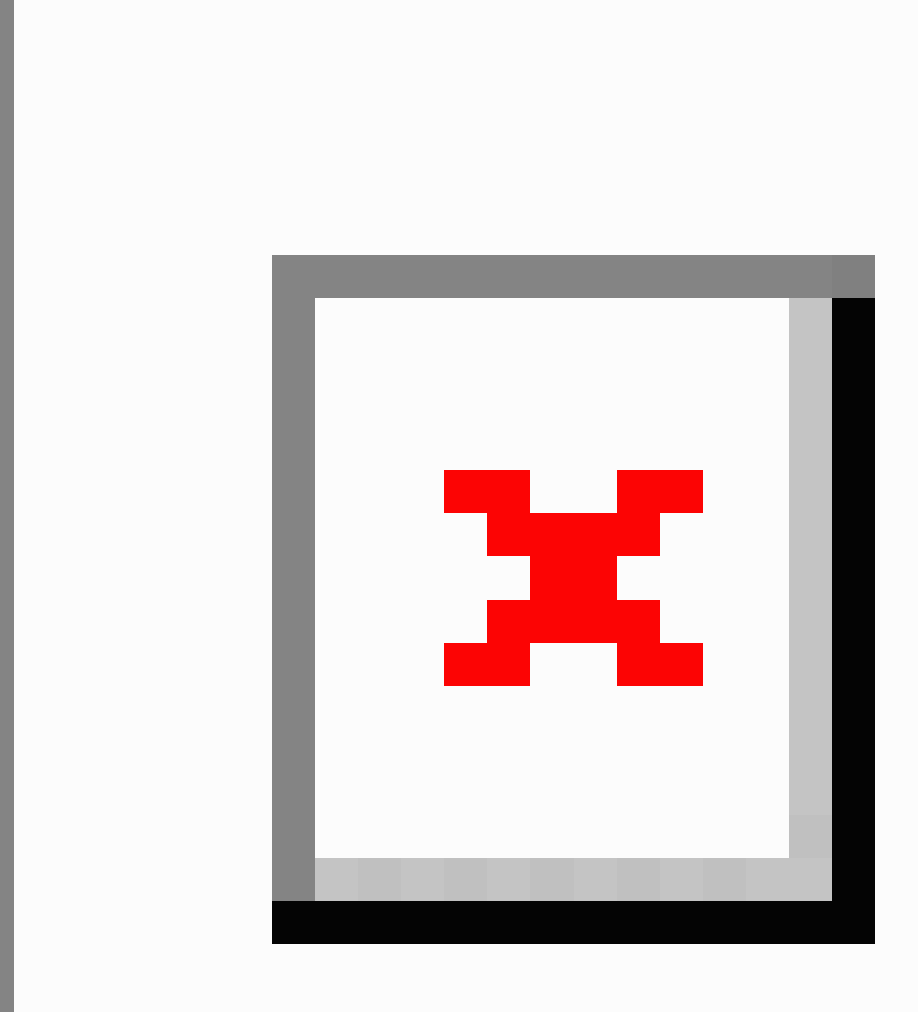
Figure 1. Flowchart of the sampling